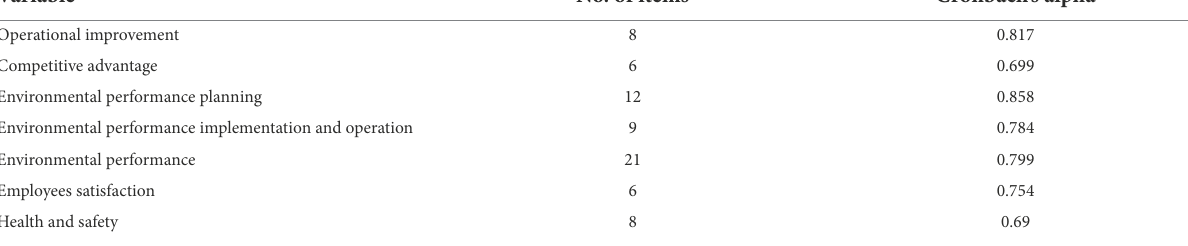
TABLE 3 Reliability statistics. Variable